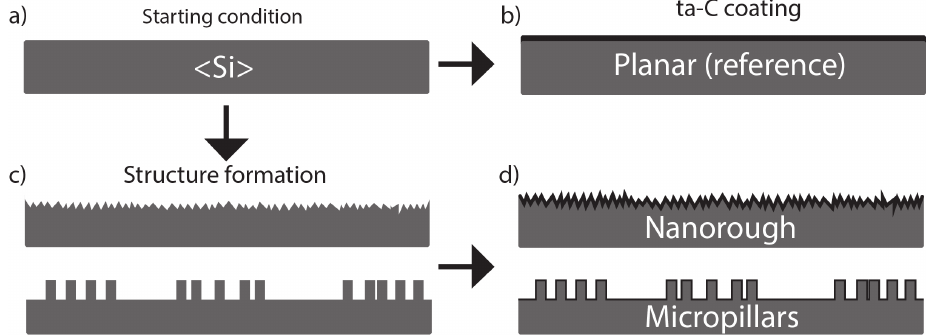
Figure 3. Fabrication process flows for ta-C samples. ( a , b ) For planar samples, ta-C was deposited directly on silicon wafer without any treatments. ( c ) For nanorough samples, the silicon wafer was anisotropically etched to produce random pyramid-like roughness on the surface before ta-C deposition. For pillars (three different layouts, two sizes) the silicon wafer was etched with patterned Cr hard mask on the surface. ( d ) After structuring, the ta-C was coated on the